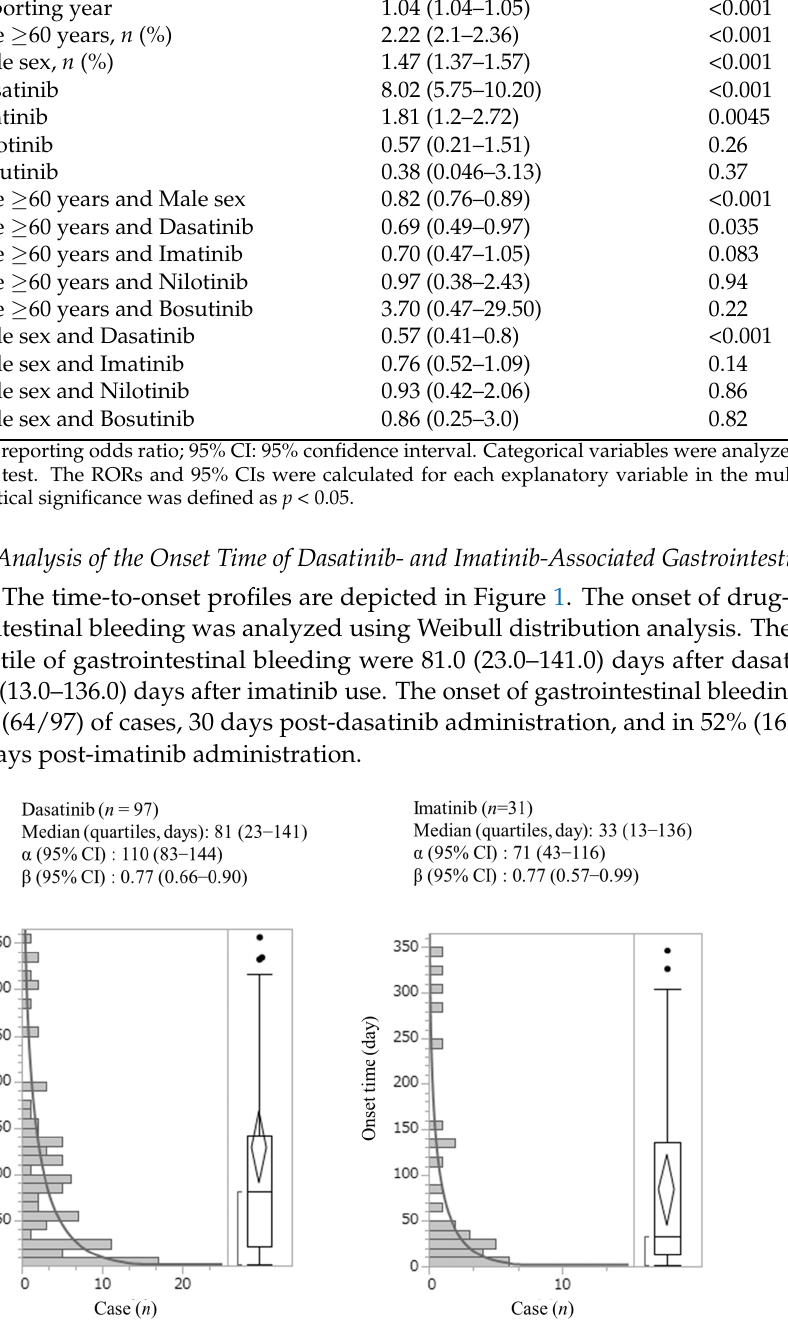
Figure 1. Number of gastrointestinal bleeding cases associated with dasatinib and imatinib by onset time in the JADER database. The time-to-onset dasatinib was 81.0 (23.0–141.0) days. The time-to- onset imatinib 33.0 (13.0–136.0) days. Black dots showed